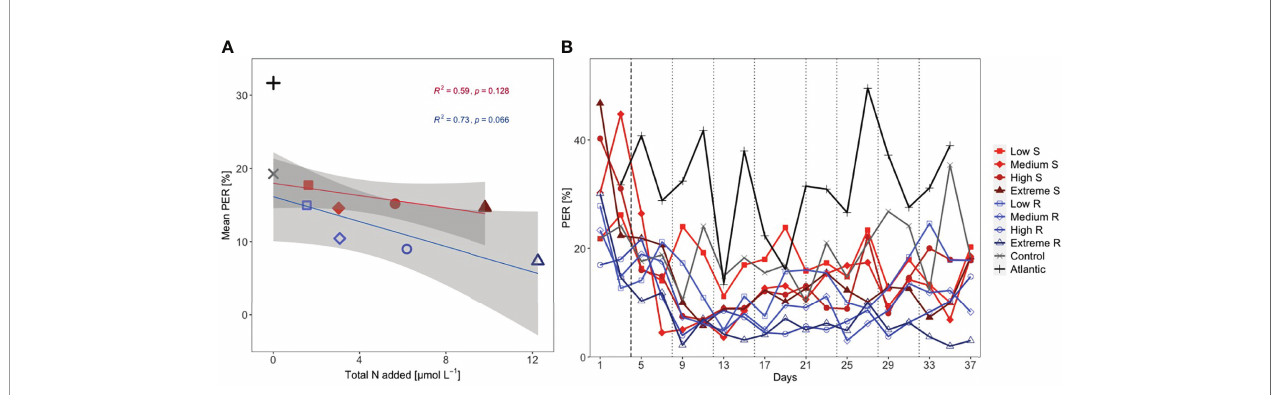
FIGURE 2 | (A) Mean percentage extracellular release (PER) per total amount of added nutrients (shaded area: 95% CI) and (B) temporal development of PER. Linear regression analysis shown for Singular (S; n = 5) and Recurring (R; n = 5) treatments. Dotted lines represent DW additions, dashed line marks the single DW addition to